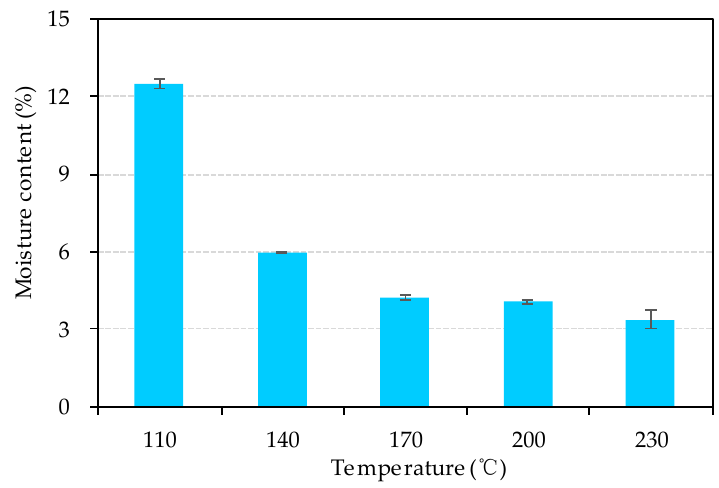
Figure 8. Moisture content of bio-board at different temperature.